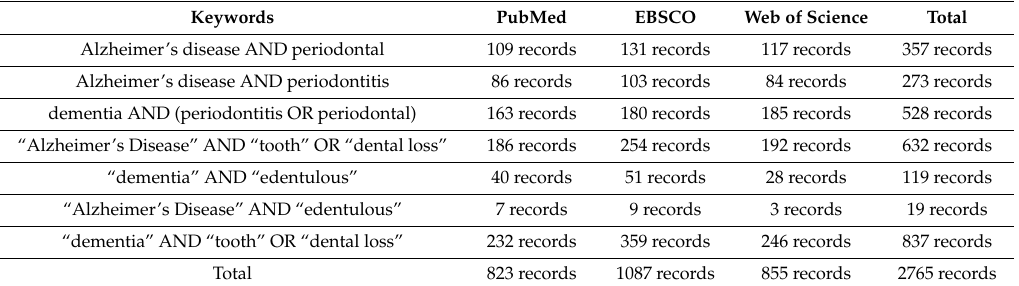
Table 1. Search table summarizing records from PubMed, Web of Science, and